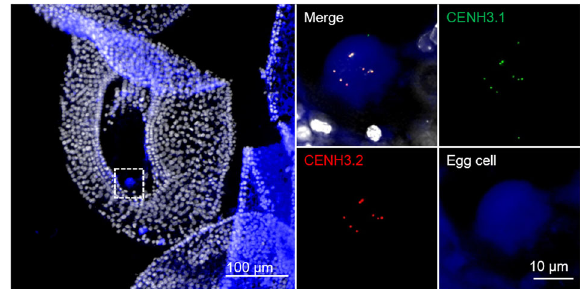
Fig. 6 Tissue section of an isolated mature ovule revealing the organization of cowpea centromeres in the egg cell. Both CENH3.1 (green) and CENH3.2 (red) localize at centromeres of the egg cell. The egg cell was identi fi ed with an egg cell-speci fi c fl uorescence marker (blue), which is driven by the A. thaliana DD45 promoter. A further enlarged egg cell region is indicated in the left picture (tissue section of a mature ovule).